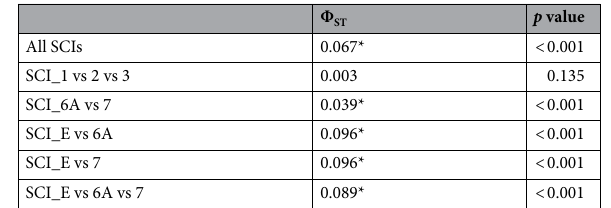
Table 3. Analysis of molecular variance (AMOVA) between scampi fishery management areas (SCIs) based on 983 loci. SCI_E is composed of SCI_1, SCI_2 and SCI_3. Φ ST (Phi- ST statistic) values that were found to be significant ( p value < 0.05) are marked (*).